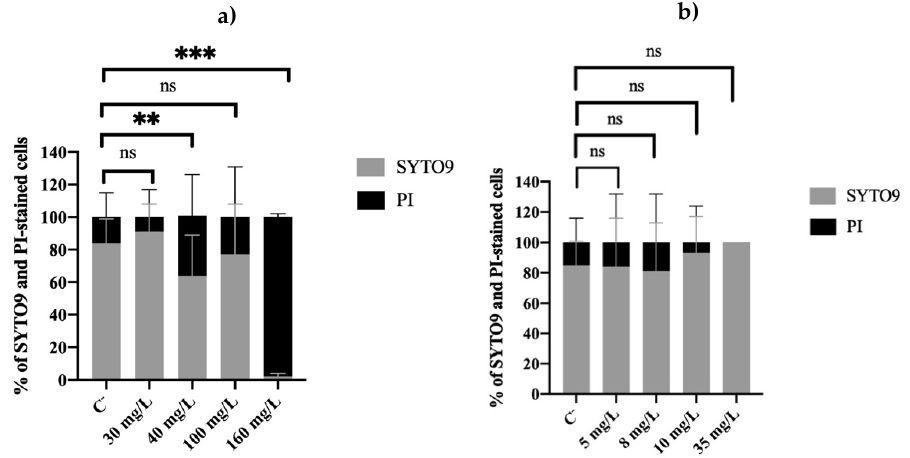
Figure 2. Percentage of Pseudomonas fluorescens cells stained with SYTO9 (green cells, light grey) and propidium iodide (red cells, black) after an overnight step in a nutrient medium, resulting from previous exposure to different concentrations of ( a ) BAC and ( b ) DBNPA for 30 min. Controls were performed with untreated cells (C − ). The means ± SD of three independent experiments are presented. ‘ns’ indicates not significant ( p > 0.05), whereas the asterisks indicate statistical significance (** p < 0.01 and *** p < 0.001), using Tukey’s multiple comparison test.